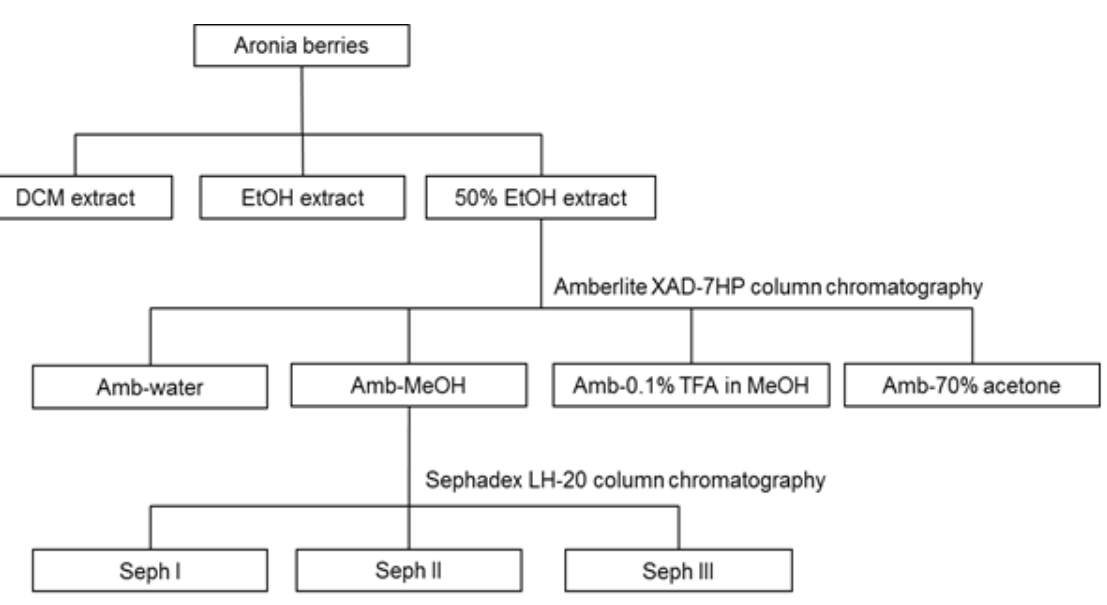
Figure 3. Procedure for extraction and fractionation from berries of Aronia. Anthocyanins (section 2.4.) and procyanidins (section 2.5.) were extracted by different